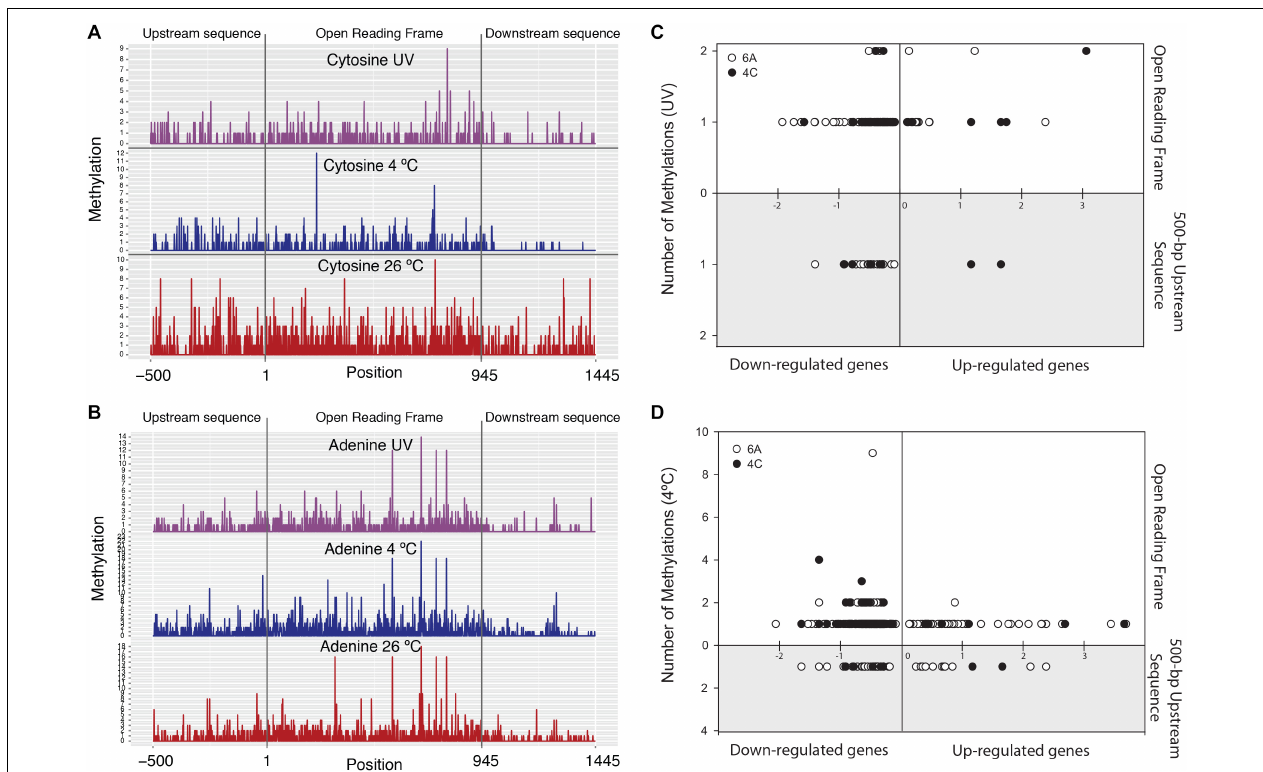
FIGURE 3 | Left panel plots show number of methylations on: (A) cytosine and (B) adenine nucleotides belonging to average length of all genes in the genome (with averaged 500-bp up- and downstream sequences) in three different treatments. Right panel plots show total number of methylations coinciding with transcriptional profiles in: (C) UV-irradiated sample and (D) 4 ◦ C-incubated sample. X -axis: up-regulated genes (positive) and down-regulated genes (negative). Y -axis: number of adenine (o) and cytosine ( • ) methylations. Upper panel X -axis: methylation count within the genes. Lower, gray-shaded panel: number of methylations in 500-bp upstream region of